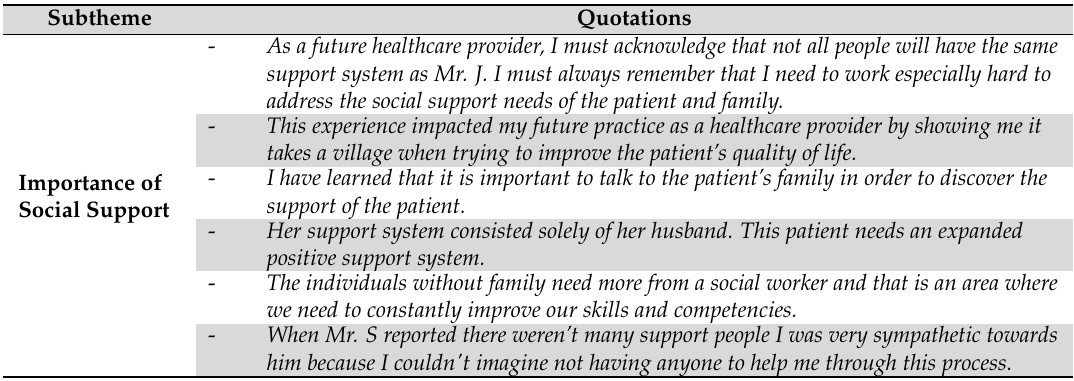
Table 7. Quotes related to the subtheme of importance of social support.